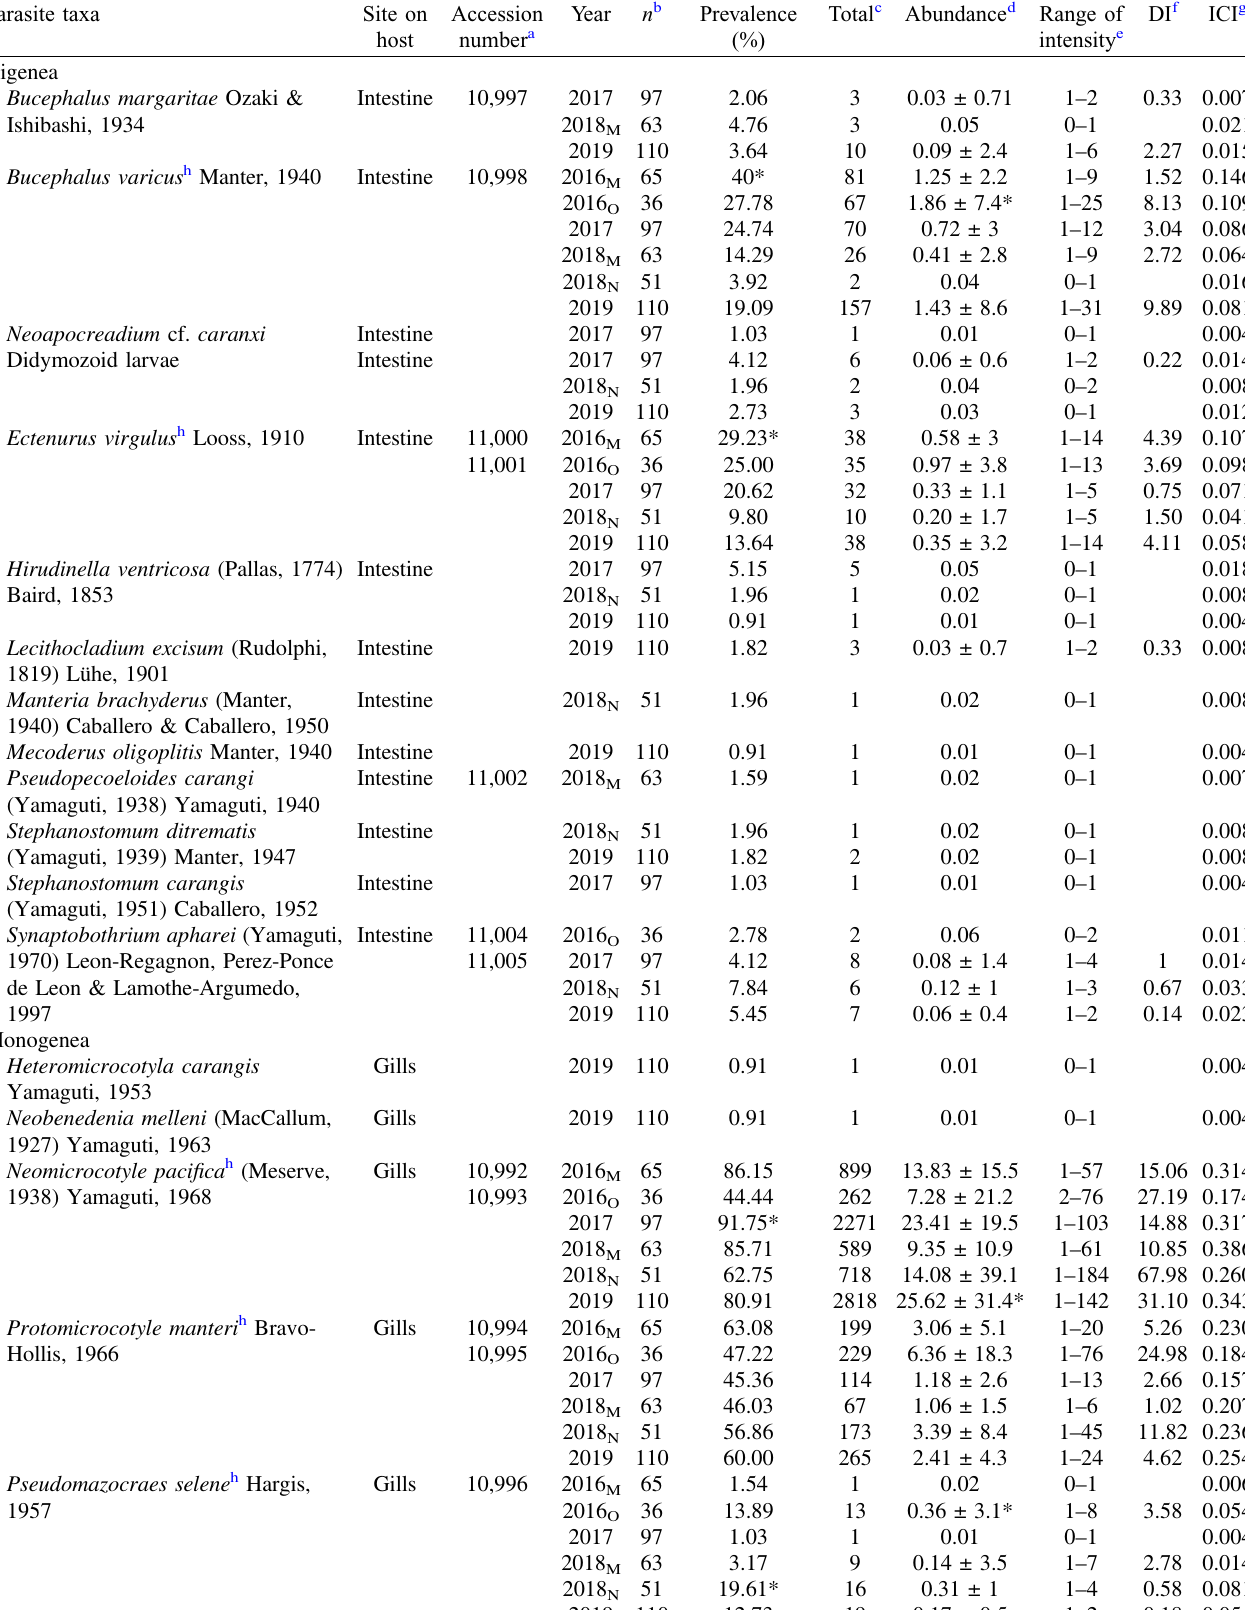
Table 1. Parasite infection parameters for Caranx sexfasciatus from Acapulco Bay, Mexico. Parasite